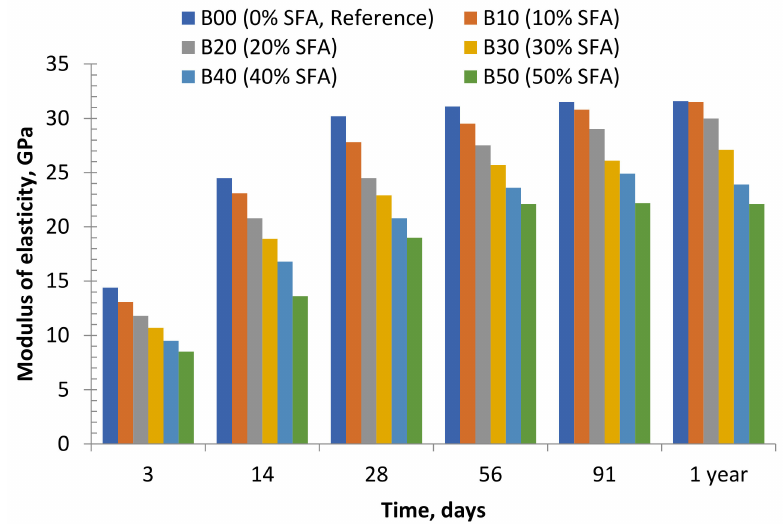
Figure 14. Modulus of elasticity versus age of Saudi FA (SFA)-based concrete [41]. Reprinted with permission from Elsevier